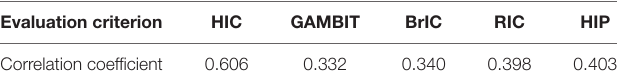
TABLE 5 | Correlation coefficients between calculated injury criteria and